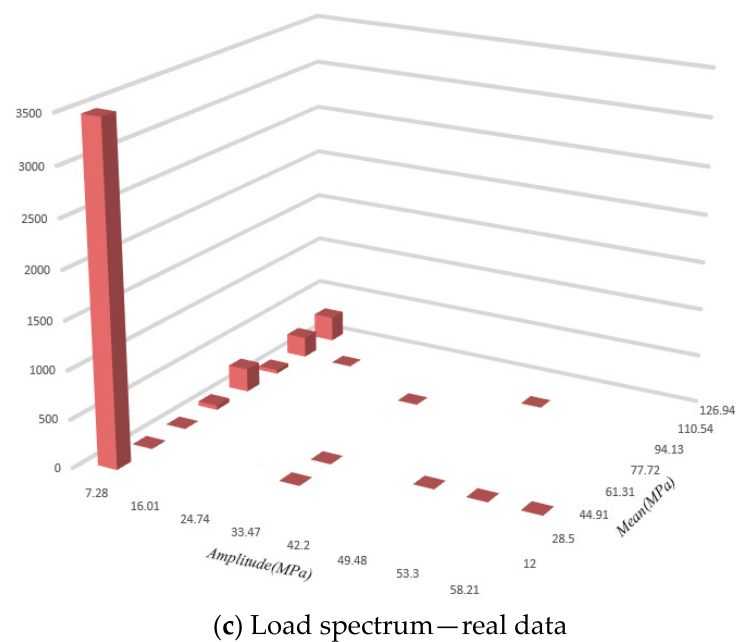
Figure 10. Eight-level load spectrum frequency distribution.